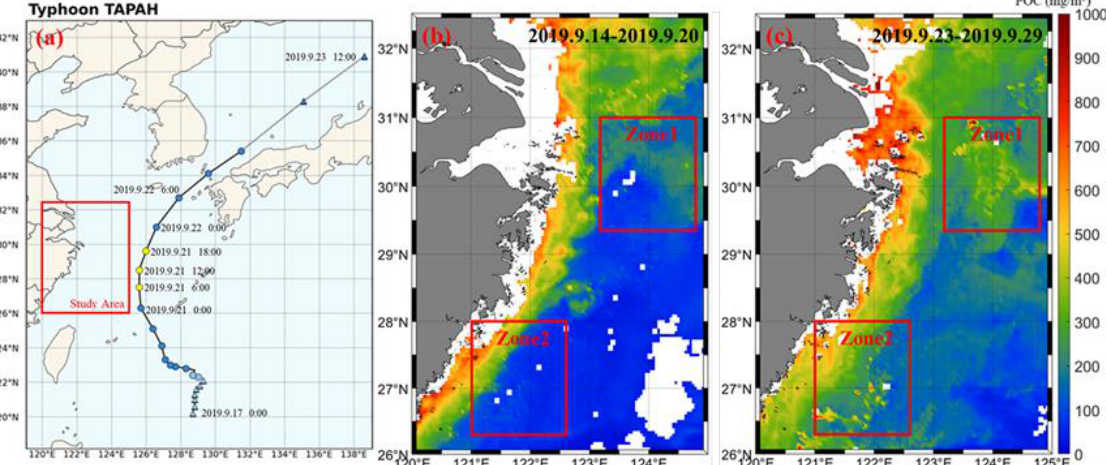
Figure 9. ( a ) is the distribution map of the path of Typhoon TAPAH, and ( b , c ) are the composite maps of the POC concentration distribution for seven days before and after the typhoon’s transit, respectively (red boxes are the selected subregions).